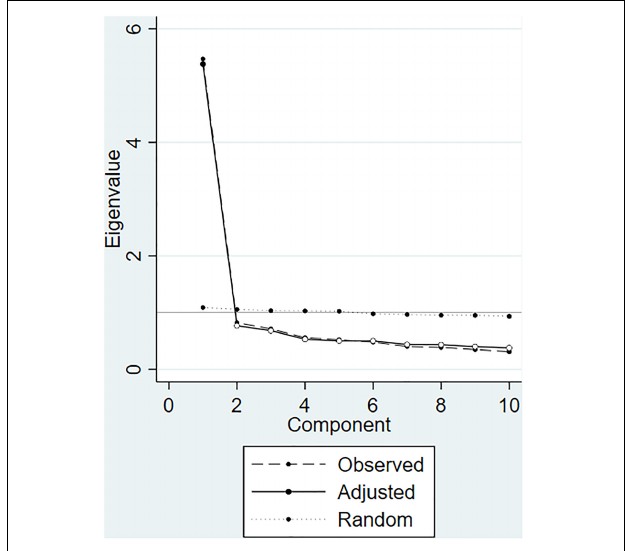
FIGURE 1 | Parallel analysis for determining the number of factors to retain for the exploratory factor analysis in the population-based sample ( N = 687).